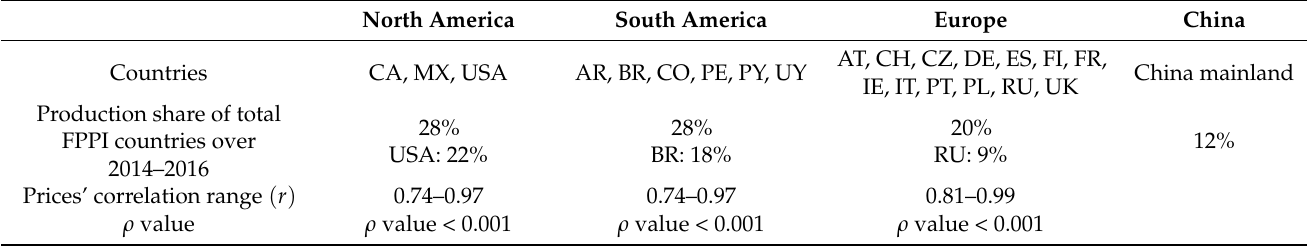
Table 1. Overview of the introduced regional FPPIs, source: own illustration.